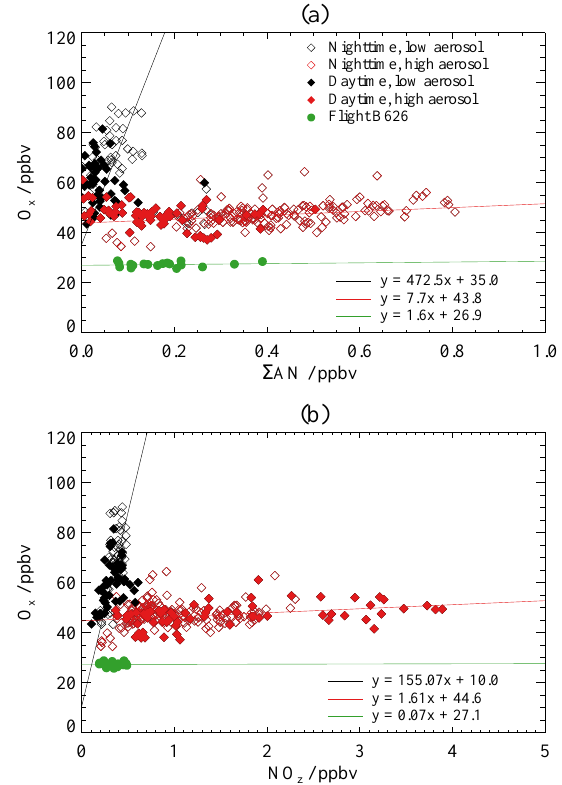
Fig. 8. Relationship between (a) O x (O 3 +NO 2 ) and alkyl nitrates ( Σ AN), and (b) O x and NO z (NO y -NO x ) measured in boreal biomass burning plumes from the BAe-146 over the course of the BORTAS measurement campaign. Night-time and daytime measurements are represented by open and closed diamonds, respectively. Black symbols represent measurement with black carbon mass concentrations less than 0.1 µ gcm − 3 and red symbols with black carbon mass concentrations greater than 0.1 µ gcm − 3 . Measurements made on flight B626 over the fire region in Northwestern Ontario are treated separately and are represented by green circles.